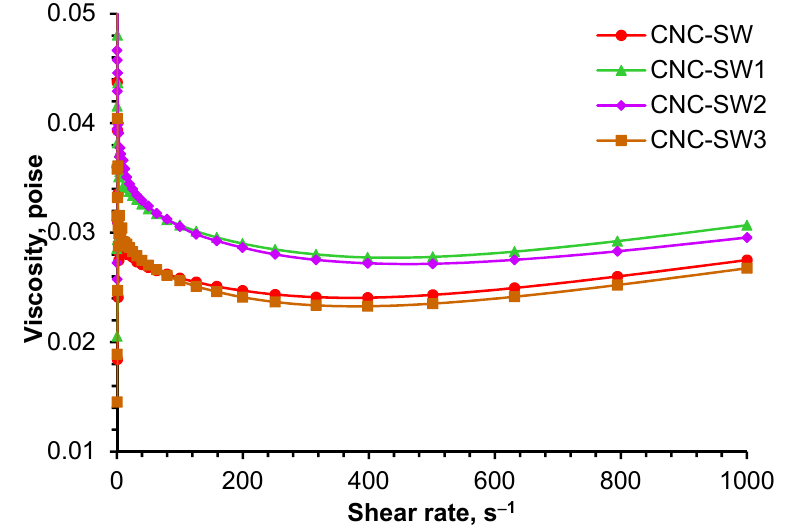
Figure 8. Viscosity measurements of CNC from SW and oxidized SW.